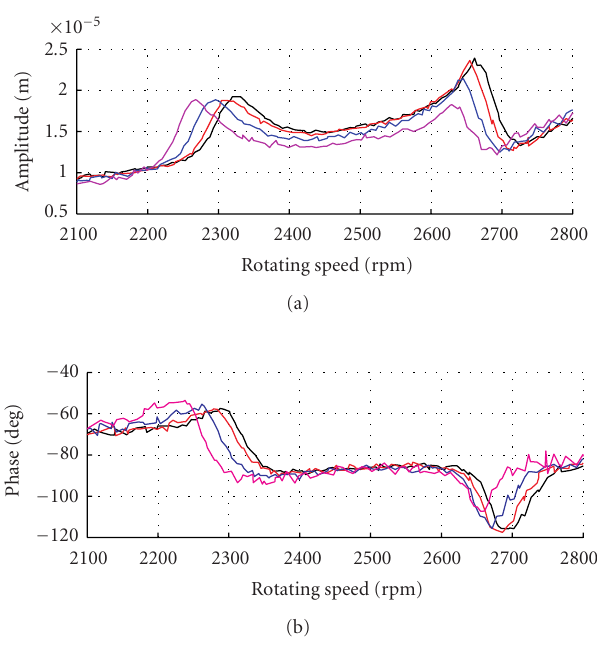
Figure 19: Unbalance responses of the 1st order for various bearing temperatures at the plane location A3 (black line = 25 ◦ C; red line = 35 ◦ C; blue line = 40 ◦ C; magenta line = 48 ◦